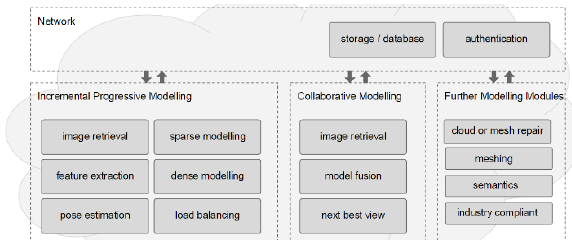
Figure 1: The overall architectures and functions of REPLICATE image-based 3D modelling